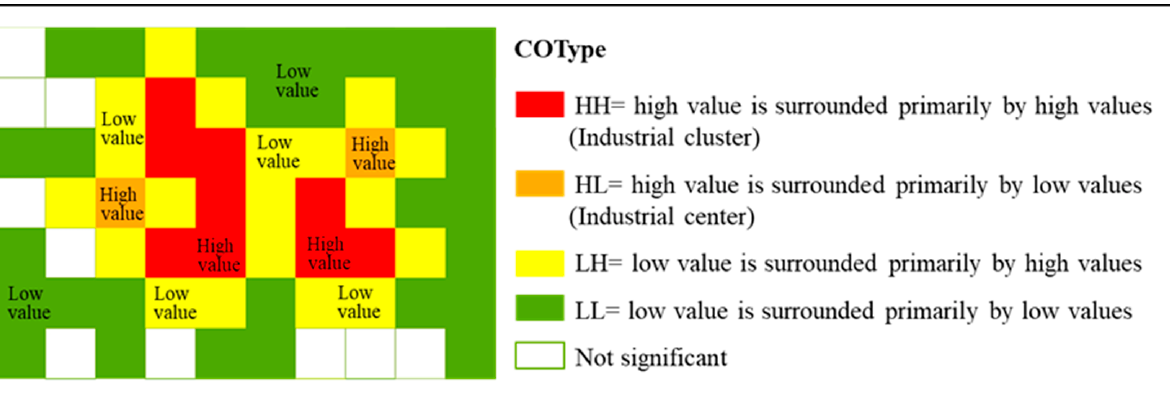
10 of 20 Figure 2. Average nearest neighbor analysis Source: Edited figure from Esri ArcGIS (https://desktop.arcgis.com/en/arcmap/10.3/tools/spatial-statistics-toolbox/average-nearest- neighbor.htm (accessed on 13 January 2023)). 5.2. Local Moran’s I